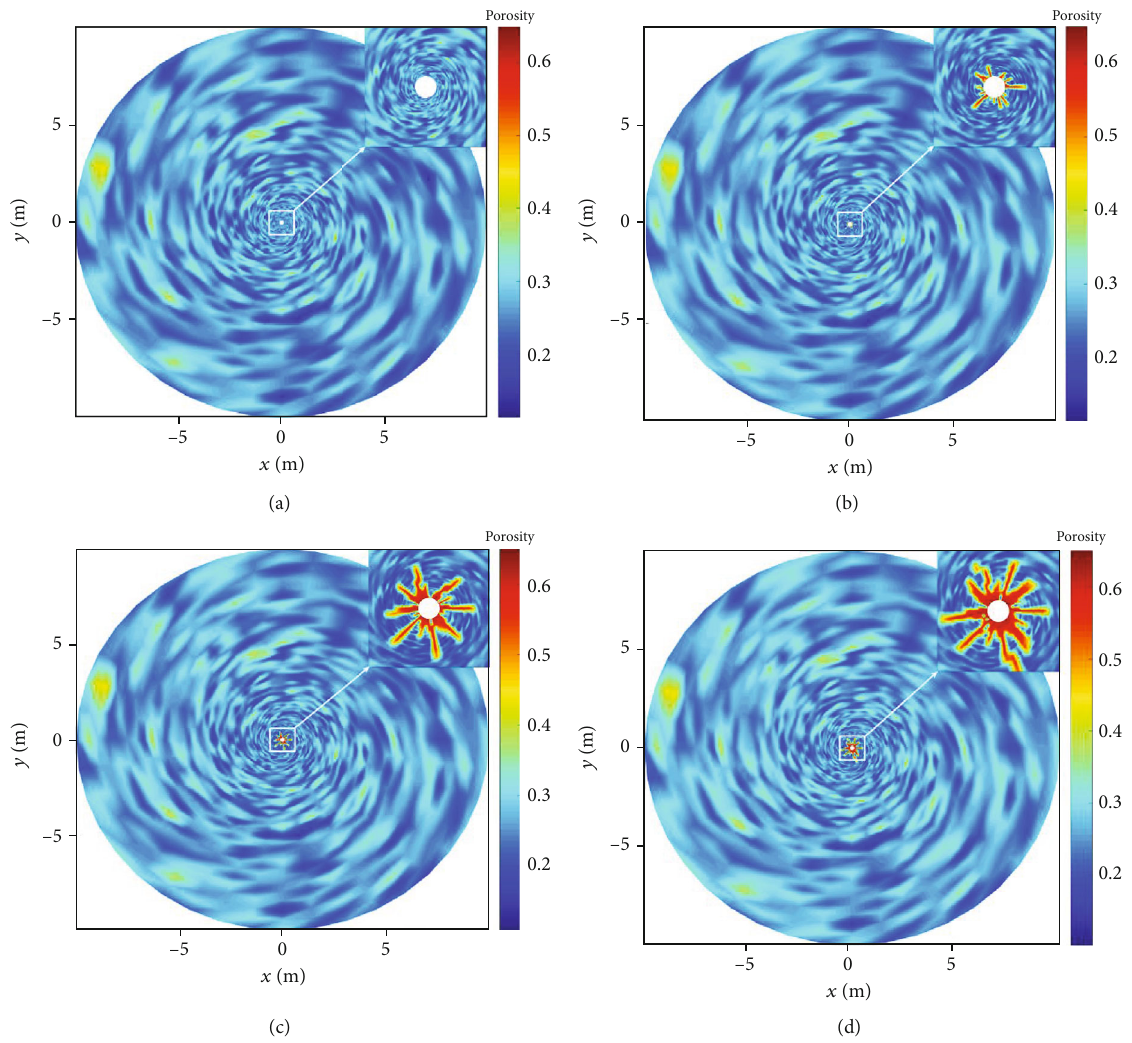
Figure 6: Porosity distribution near the injection well for di ff erent injection pressures. (a) p p = 21 MPa w